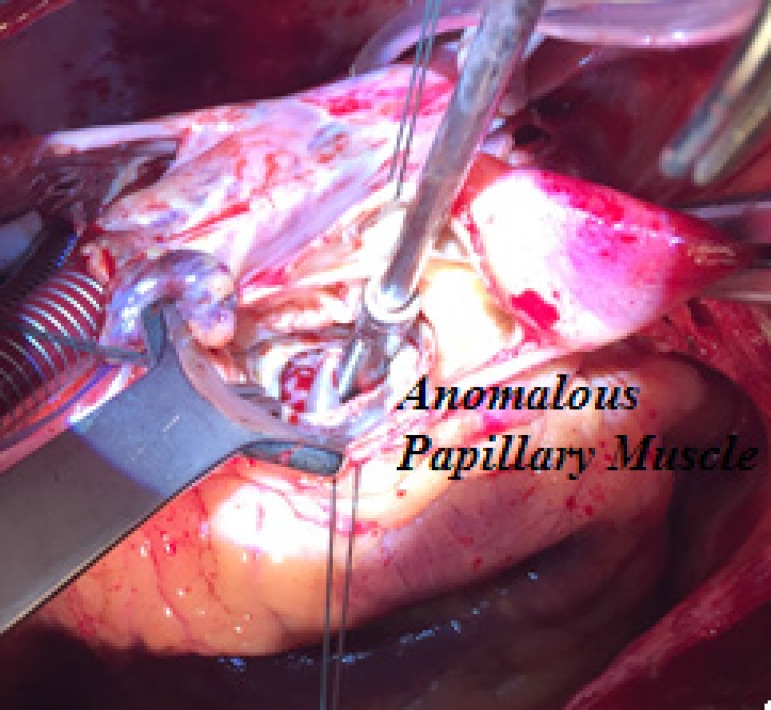
Surgical aspect.